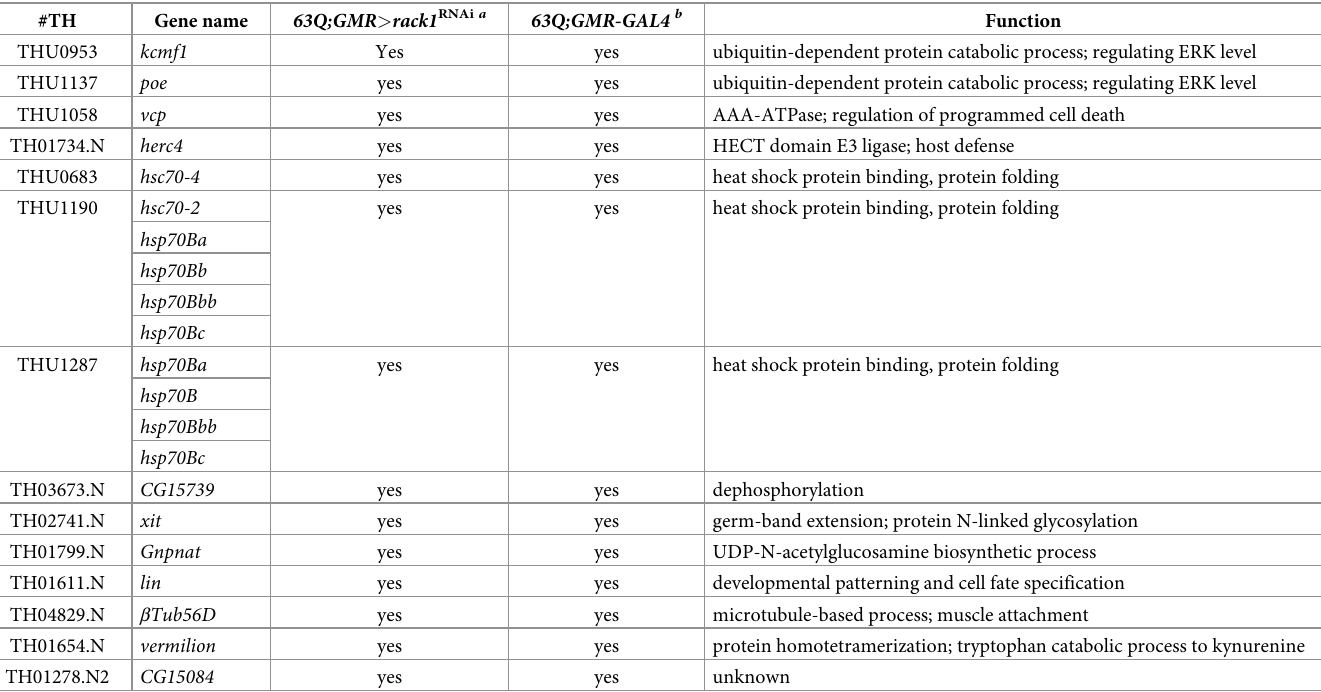
Table 1. RNAi alleles that further suppressed polyQ-mediated cytotoxicity in combination with rack1 knock down.